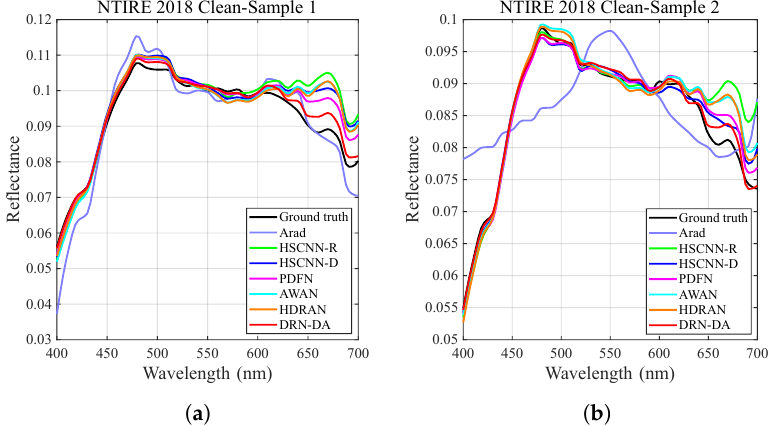
Figure 11. Spectral reflectance of selected samples from NTIRE 2018 “Clean” track. ( a ) Sample 1. ( b ) Sample 2.